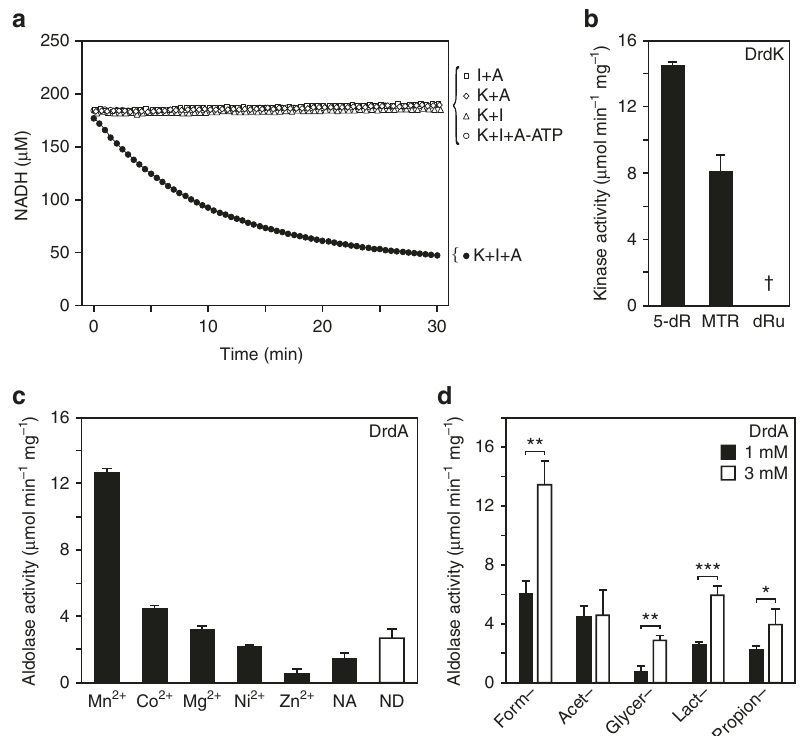
Fig. 2 Activities of the B. thuringiensis kinase (DrdK), isomerase (DrdI), and aldolase (DrdA). a Coupled assay of DHAP formation from 5-deoxyribose when DrdK (K), DrdI (I), DrdA (A), and ATP are present in the reaction. DHAP formation was tracked via glycerol 3-phosphate dehydrogenase-catalyzed oxidation of NADH. Standard deviation for each point was <5 µ M NADH. b DrdK is speci fi c for 5-deoxyribose (5-dR) and 5-methylthioribose (MTR). Reactions contained 0.5 mM sugar and 1 mM ATP. Activity against 5-deoxyribulose (5-dRu) was undetectable ( † ), as was activity against 2-deoxyribose, ribose, fucose, fructose, fructose 6-phosphate, and glucose. Data are corrected for the ATPase activity of DrdK and are the mean of three replicates; error bars are the s.d. c DrdA prefers Mn 2 + or Co 2 + as cofactor. The enzyme was prepared from E. coli grown in unsupplemented LB, isolated by Ni 2 + -af fi nity chromatography, desalted and dialyzed against EDTA to remove metals. Activity was then assayed without (NA) or with 0.1 mM metal chloride (or 2 mM for MgCl 2 , to mimic intracellular levels). The activity of the undialyzed enzyme (ND) is also shown. Data are the mean of three replicates; error bars are the s.d. d The substrate preference of DrdA, measured by the loss of DHAP after 10 min from reactions containing 1 mM DHAP and 1 or 3 mM aldehyde (identi fi ed by pre fi x). Data are the mean of three (or for acetaldehyde six) replicates; error bars are the s.d. Signi fi cance was determined by t -test, * P